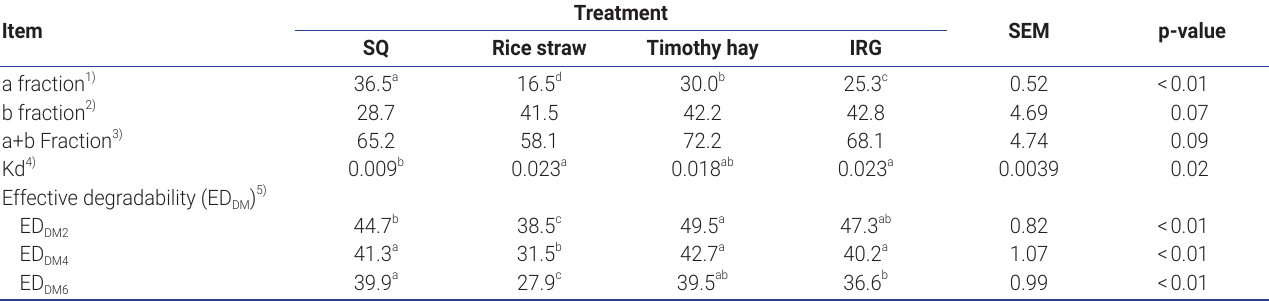
Table 7. In situ ruminal degradation characteristics of various roughage types (dry matter basis) Item